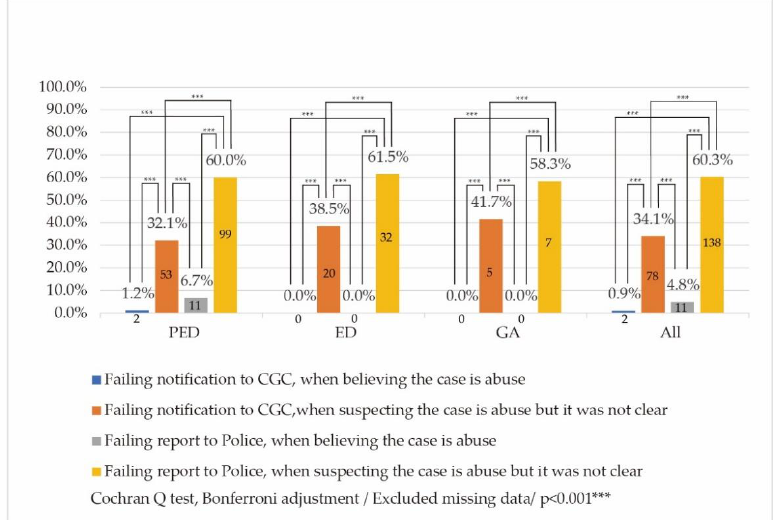
Figure 1. Failing notification to CGC/WO and reporting to the police.